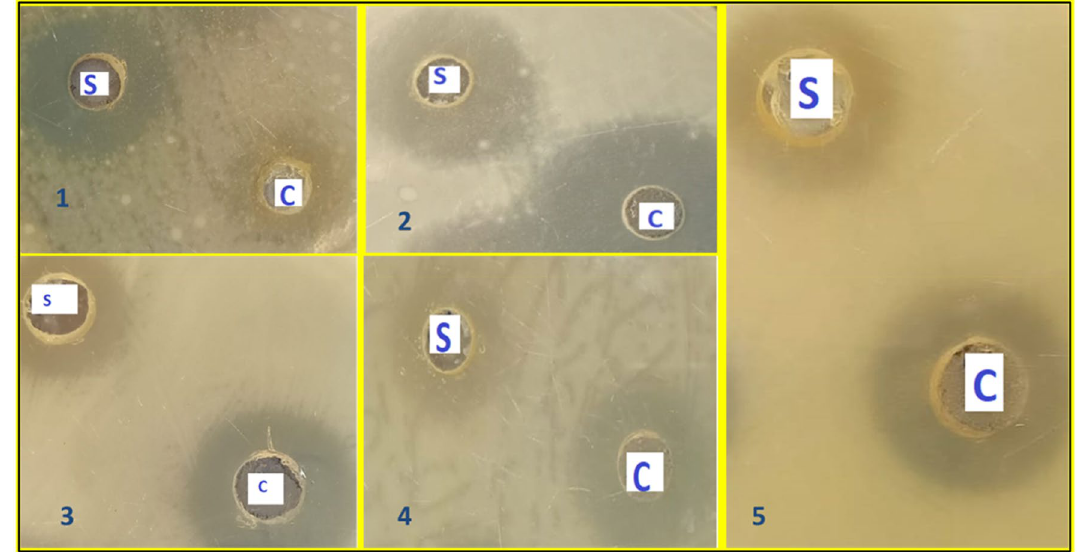
Fig. 2 Comparison between the inhibition zones of the lyophilized extracts of fermented and non‑fermented cinnamon against different pathogenic microorganisms: (S) fermented sample by S. cerevisiae ; (C) non‑fermented sample; (1) E. coli ; (2) S. typhi ; (3) S. aureus ; (4) L. monocytogenes and 50 C.